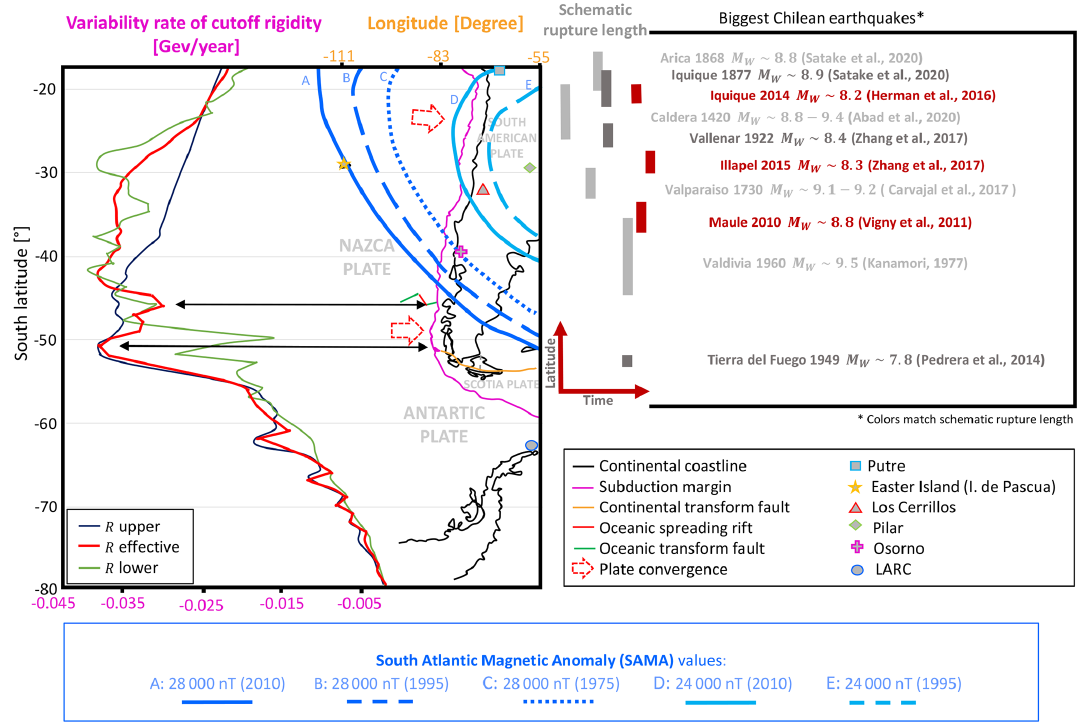
Figure 1. Left side: latitudinal effect of the geomagnetic cutoff rigidity projected over the Chilean convergent margin close to the 70 ◦ W meridian. The solid pink lines indicate the edges of tectonic plates. The Nazca Plate is from 18 ◦ N to 45 ◦ S in latitude. The South American continent is on the South American Plate. The Antarctic Plate is from 45 to 79 ◦ S. The black lines indicate the coastline. In blue are the iso-values of magnetic intensity due to SAMA proximity. The symbols indicate the stations’ locations. Right: history of Chilean